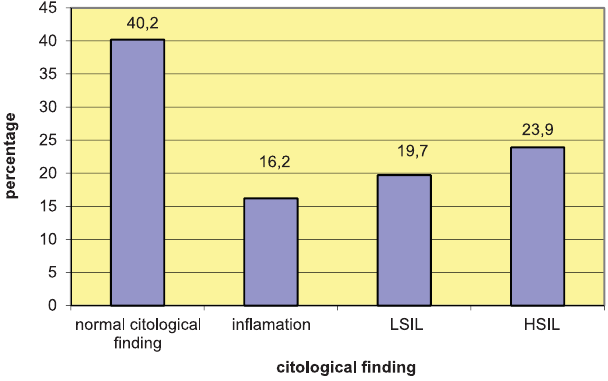
FIGURE 4. Graphical presentation of cytological fi ndings by Bethesda classi fi cation. According to the cytological fi nding 104 (40.40%) patients had normal fi ndings, in fl ammation had 42 (16.2%) patients, squamous in- traepithelial intraepithelial lesion low-grade LSIL had 51 (19.7%) patients, a squamous intraepithelial lesion high-grade HSIL had 62 (23.9%)